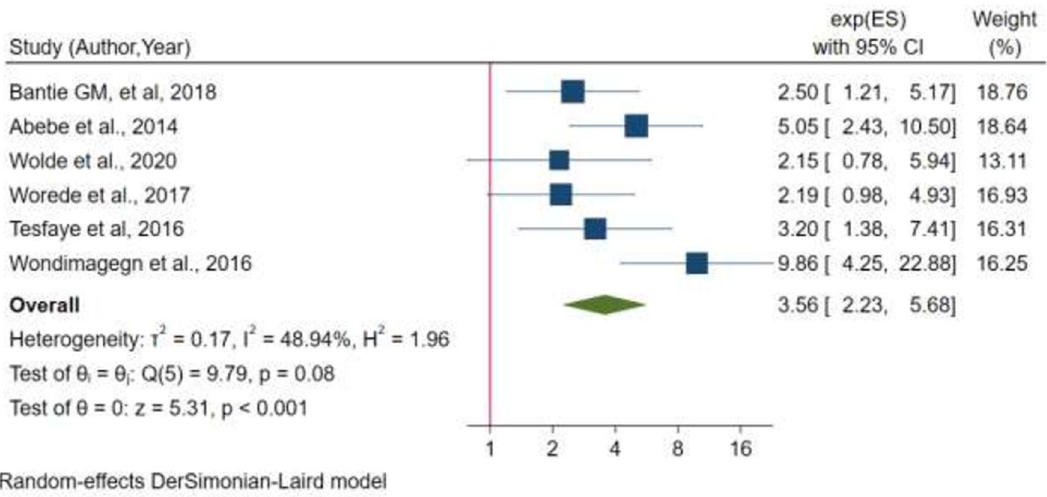
Figure 6. Forest plot for the association between family history of DM and diabetes mellitus, a systematic review and meta analysis in Ethiopia,